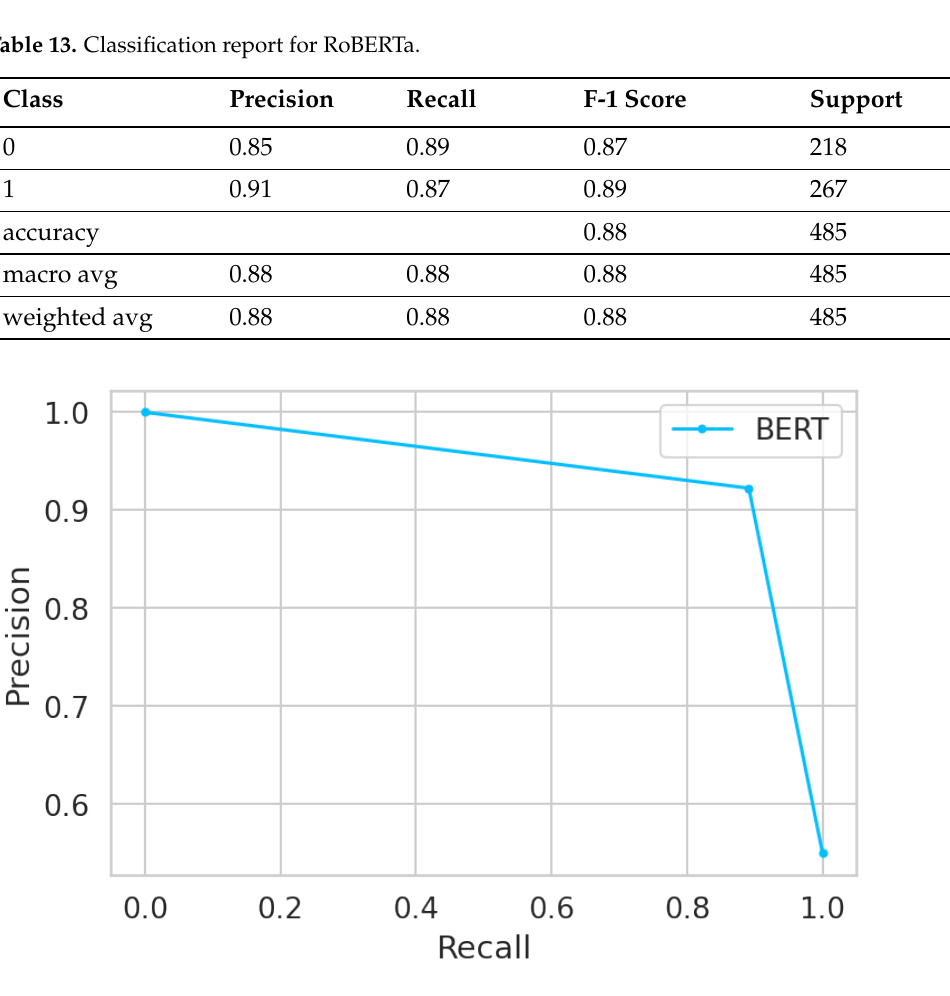
Figure 17. Precision and Recall curve for